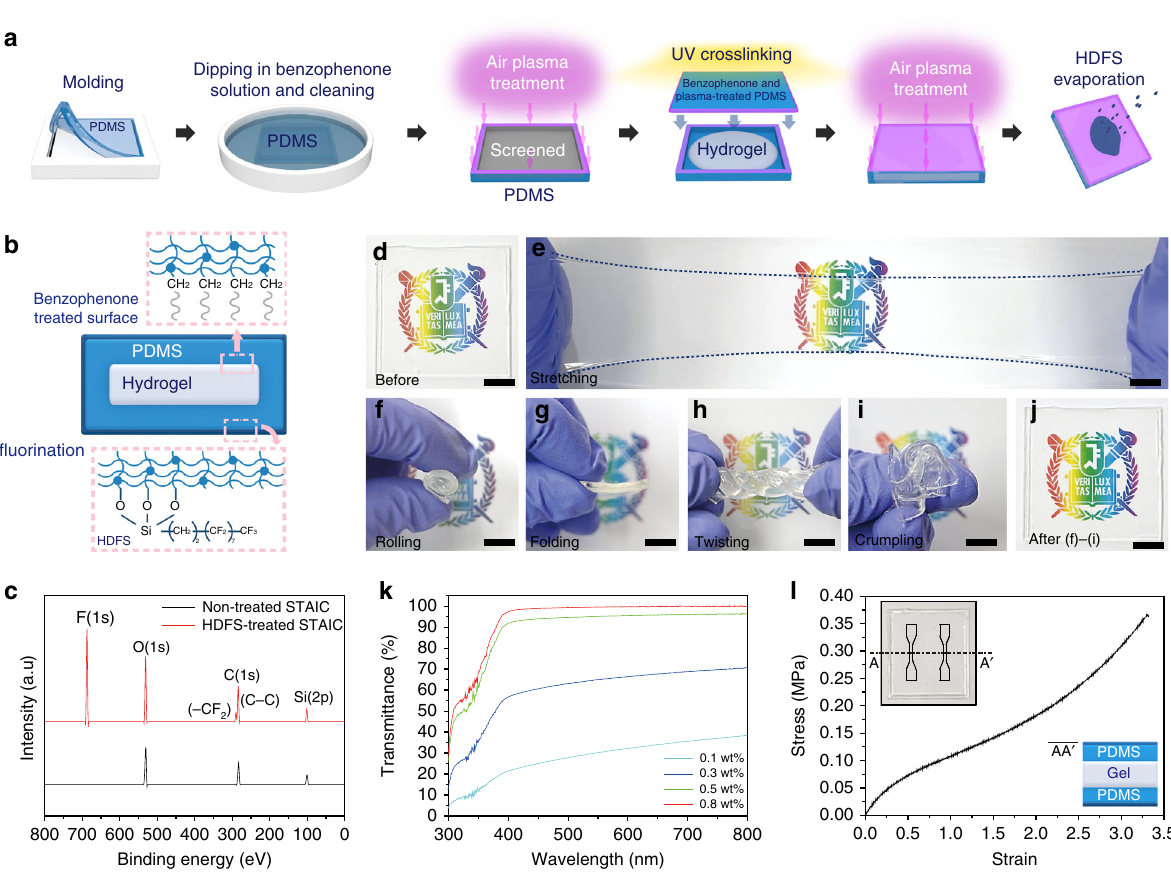
Fig. 1 Transparent and deformable ionic communicators with high mechanical and optical reliability. a Fabrication process of self-cleanable, transparent and attachable ionic communicators (STAICs). b Cross-sectional structure of fabricated STAICs. Robust interfaces were formed between PDMS and hydrogel by applying chemical anchoring with benzophenone treatments (Heptadeca fl uoro-1,1,2,2-tetrahydrodecyl)trichlorosilane (HDFS) coatings enhance triboelectric properties and provide self-cleaning ability. c X-ray photoelectron spectroscopy (XPS) analysis of HDFS-treated STAIC. d , e Fabricated STAIC was stretched with hands. f – j STAIC was subjected to different mechanical deformations sequentially and released. STAIC was f rolled, g folded, h twisted, i crumpled, and j released from the deformations. k Transmittance spectra according to various weight ratio of thermal initiator in STAIC. l Stress – strain curve of tensile test for a STAIC. (scale bar: 1 contact materials were investigated, as shown in Supplementary Fig. 3. Larger difference between electron af fi nities of contact materials led to higher triboelectric voltage outputs. In addition, the effect of time interval between consecutive contacts on the electrical output performance was investigated (Supplementary Fig. 4). Longer duration time after detachment caused lower output voltages, a result which comes from charge leakage. Fig. 2b, c show the electrical output performance depending on existence of HDFS treatment on STAICs. 24.5% of output voltage and 17.5% of output current were increased, which is possibly due to the fl uorine layer that was formed by HDFS and had larger electron binding energy than PDMS 34 . Surface modi fi cation by HDFS also protects contact surfaces from contamination during multiple instances of contact, resulting in stable electrical outputs. Notably, STAICs showed very stable outputs over 25,600 cycles as shown in Fig. 2d. Supplementary Figure 5 shows that STAICs have good anti-dehydration ability under harsh conditions rela- tive to the bare hydrogel due to the outer coating of PDMS. Bare hydrogel noticeably shrinks after 3 h in a desiccator and its weight decreases by 72.5%, while that of the STAIC decreases by only 2.8%. Electrical outputs of the STAICs were examined under various uniaxial strains as shown in Supplementary Fig. 6. When 200% of strain was applied, the output voltages slightly increased